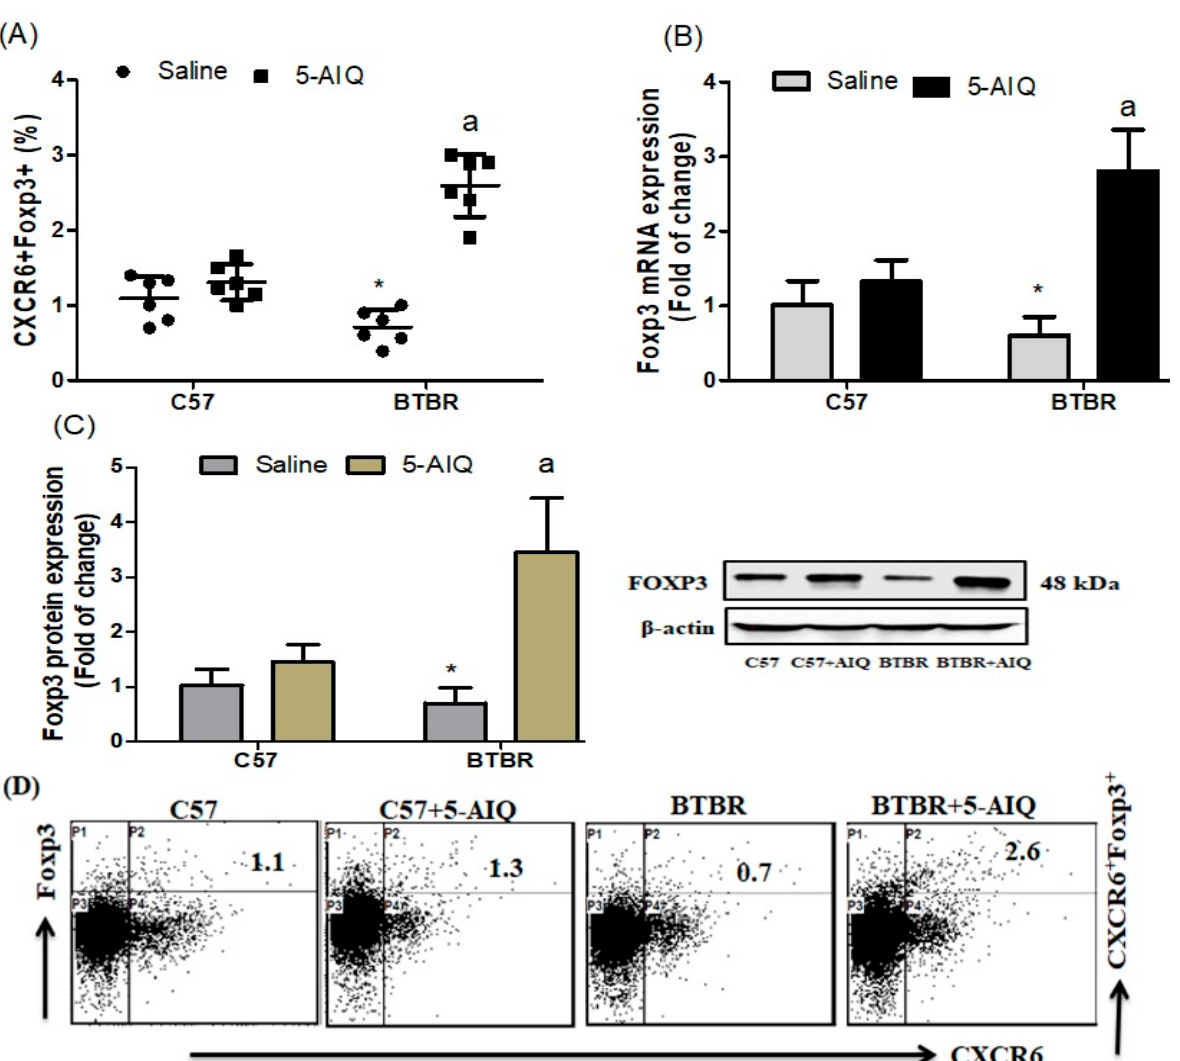
Figure 1. Effects of 5-AIQ on FOXP3 expression in C57 and BTBR mice. ( A ) Flow cytometry analysis of intracellular FOXP3-producing CXCR6+ T cells from mouse spleens (Strain effect, F(1,20) = 13.39, p < 0.0016; Treatment effect, F(1,20) = 71.37, p < 0.0001, Treatment x Strain effect, F(1,20) = 45.01, p < 0.0001); ( B ) Reverse Transcriptase Quantitative PCR (RT-qPCR) analysis of levels of FOXP3 mRNA from mouse brain tissue (Strain effect, F(1,20) = 12.52, p < 0.0021; Treatment effect, F(1,20) = 68.44, p < 0.0001, Treatment x Strain effect, F(1,20) = 38.81, p < 0.0001) and ( C ) Western blotting analysis of levels of FOXP3 protein from mouse brain tissue (Strain effect, F(1,20) = 13.48, p < 0.0015; Treatment effect, F(1,20) = 48.34, p < 0.0001, Treatment x Strain effect, F(1,20) = 26.23, p < 0.0001). ( D ) Cells were gated on forward-side scatter dot plots; the dot plots represent the percentages of CXCR6+FOXP3+ cells. Bar graphs represent the percentage of CXCR6+FOXP3+ population. The control C57 and BTBR mice received saline intraperitoneal injection. Treated BTBR and C57 mice received 5-AIQ (1.5 mg/kg) via intraperitoneal injection once daily for ten days. The results are shown as the means ± SD, n = 6, each group; * p < 0.05 compared with saline-treated C57 mice; a p < 0.05 compared with saline-treated BTBR mice.